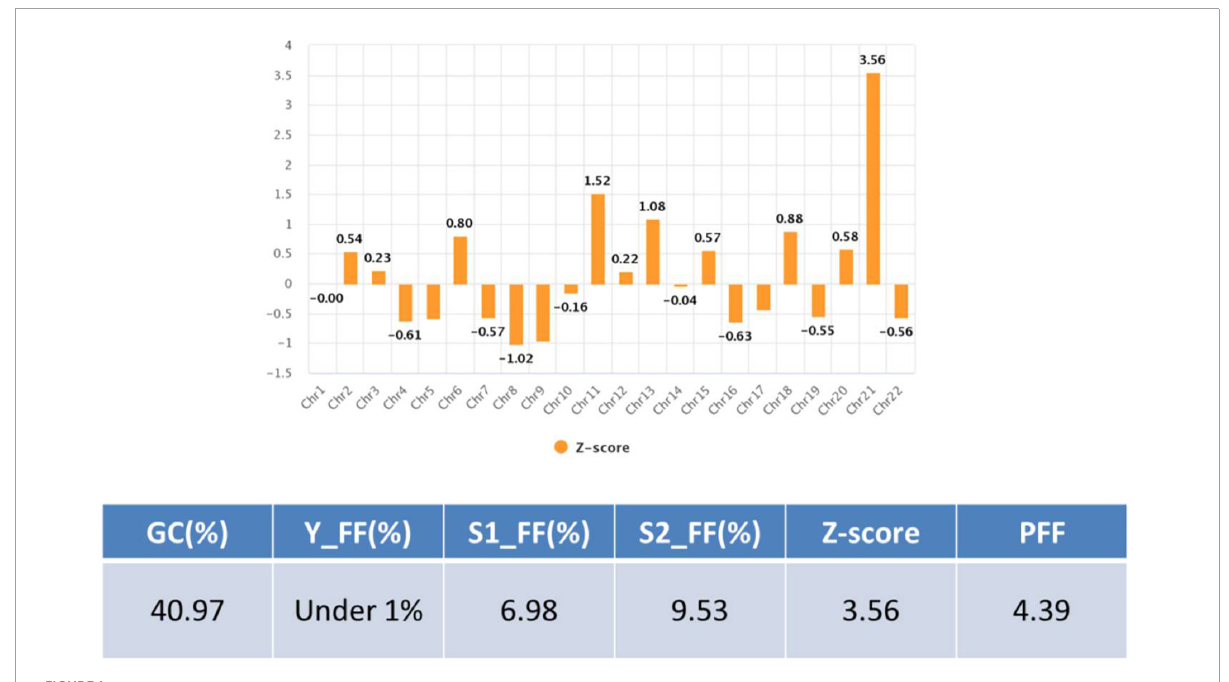
FIGURE1 Non- invasive prenatal testing (NIPT) data in case